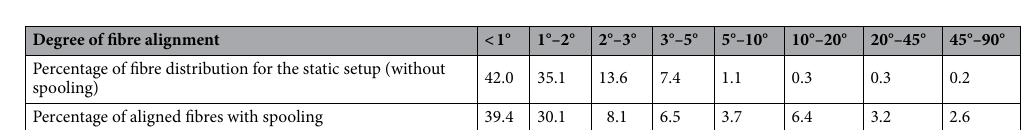
Percentage of fibre distribution for the static setup (without